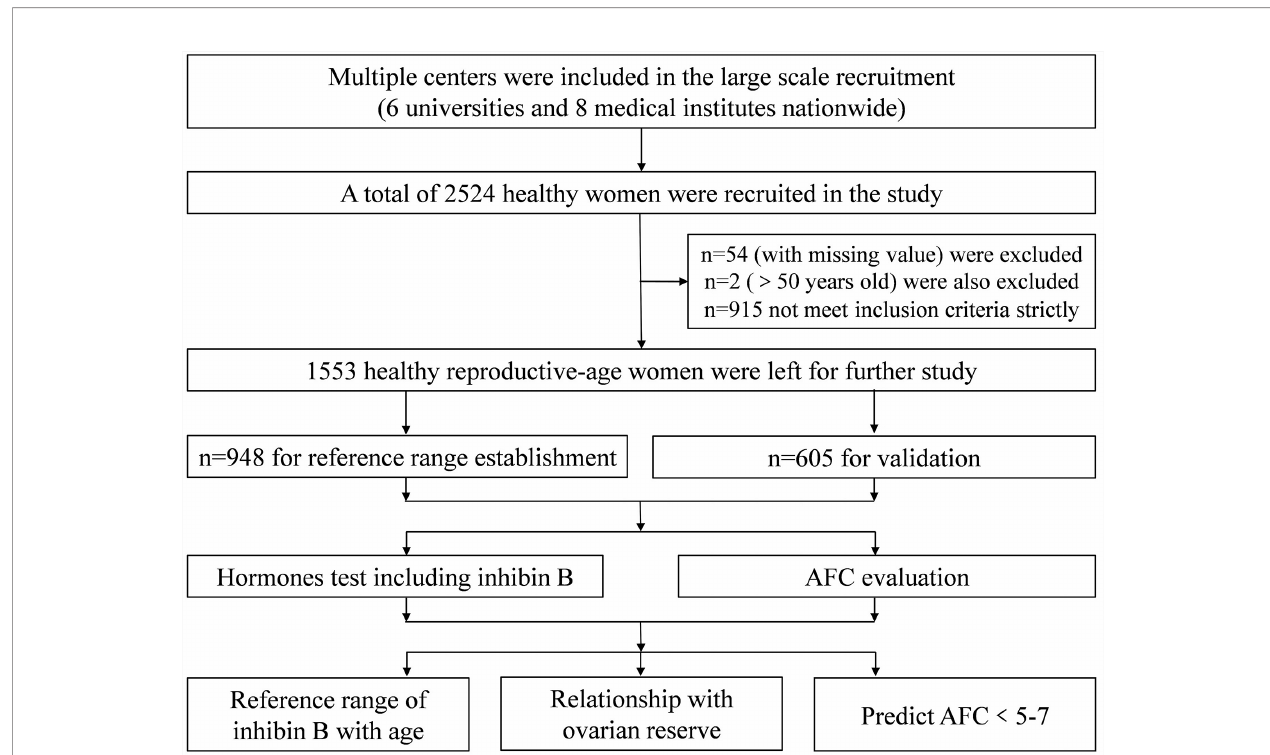
FIGURE 1 | The fl owchart of this